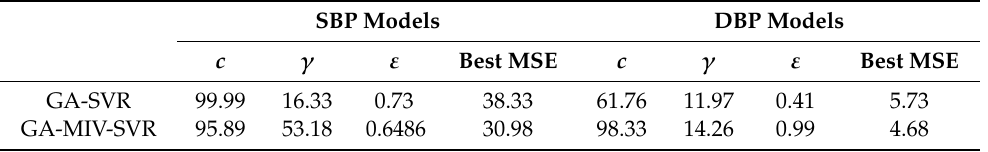
Figure 7. GA optimization process after dimensionality reduction, the MSE served as the fitness value of individuals in each generation. ( a ) SBP model. ( b ) DBP model. Table 4. Parameters of SBP and DBP models using GA optimized SVR and comparison between before and after MIV dimensionality reduction, the Best MSE represented the model accuracies.